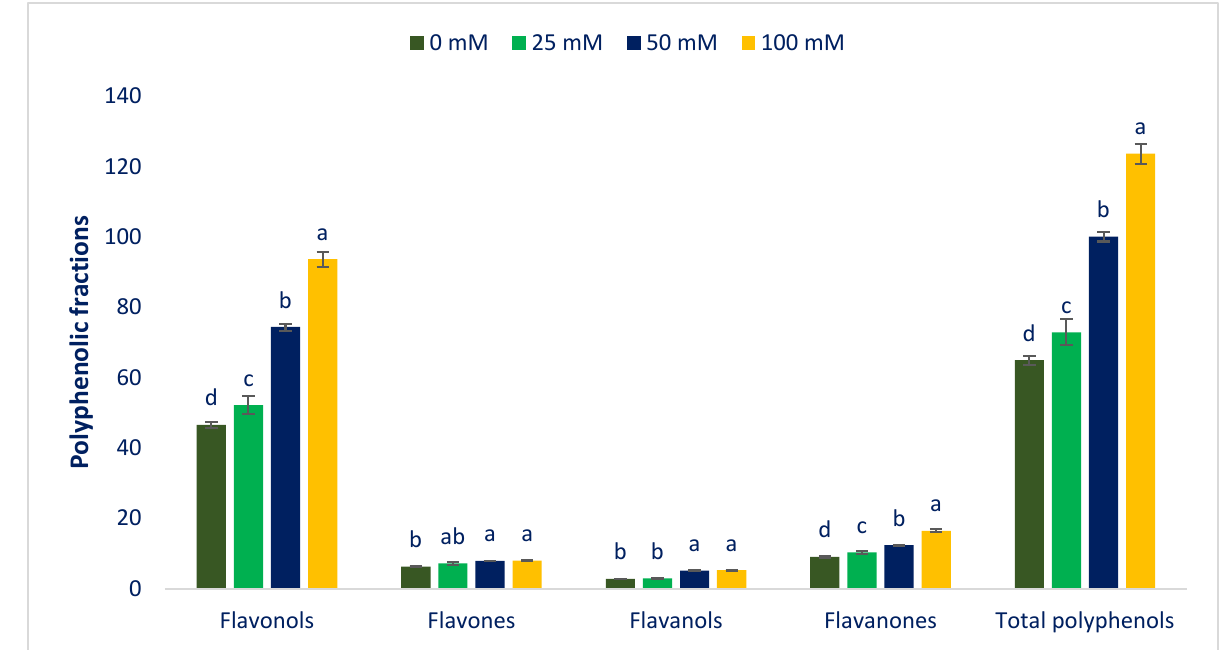
Figure 11. Impact on polyphenolic fractions of Lalshak under salt stress ( n = 6). Dissimilar letters in the bars varied significantly by DMRT ( p < 0.01).